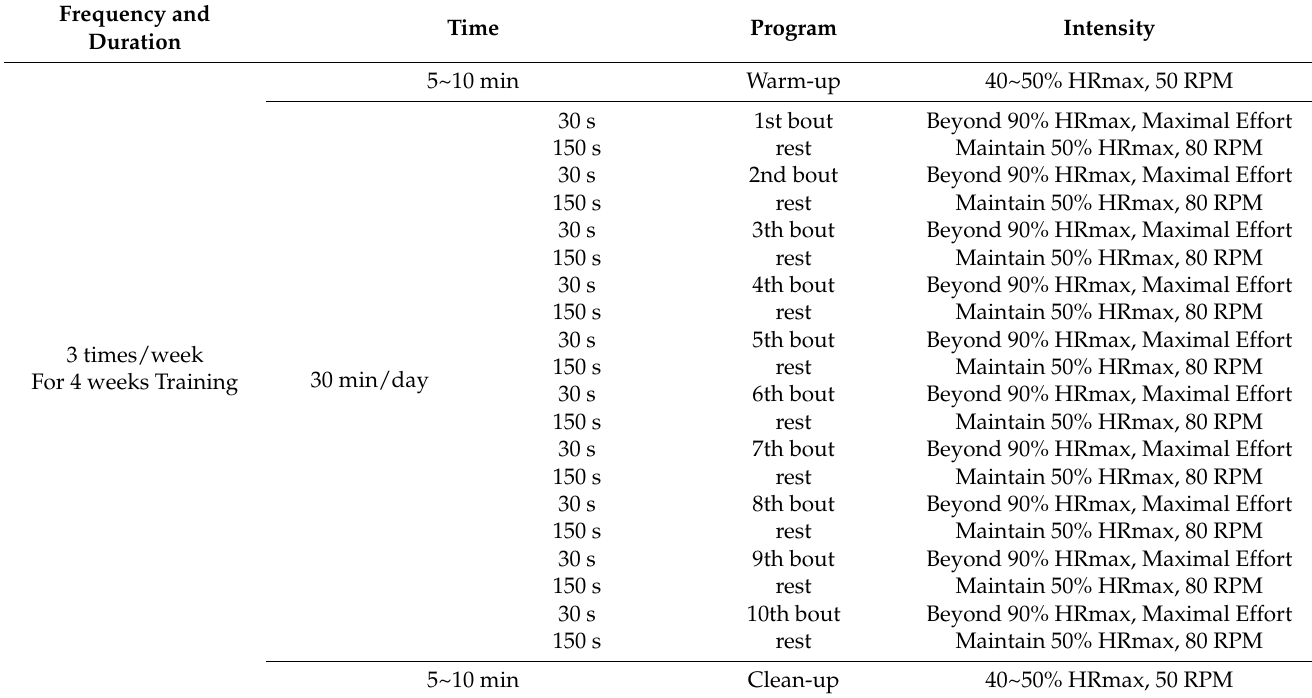
Table 1. Specific program of High-Intensity Interval Training